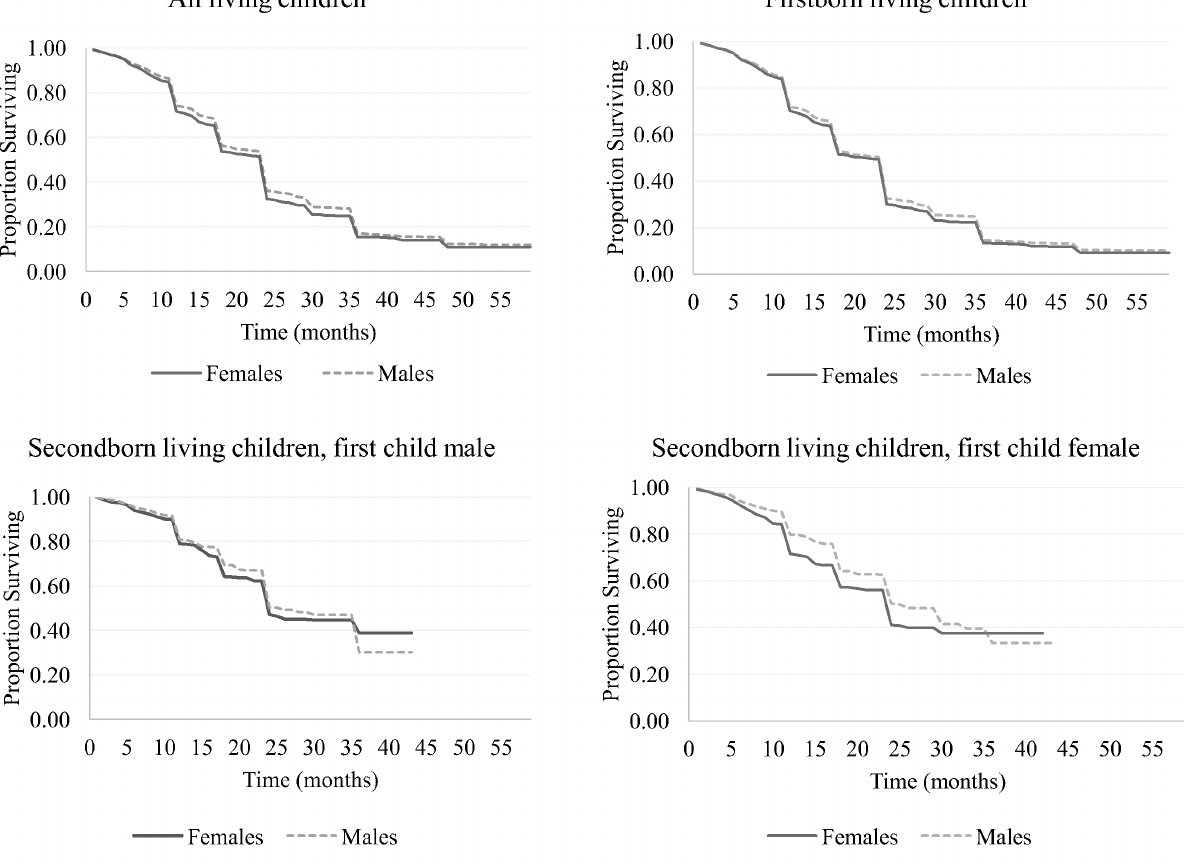
Figure 1. Kaplan Meier curves for breastfeeding duration by gender and birth order, NFHS-3.